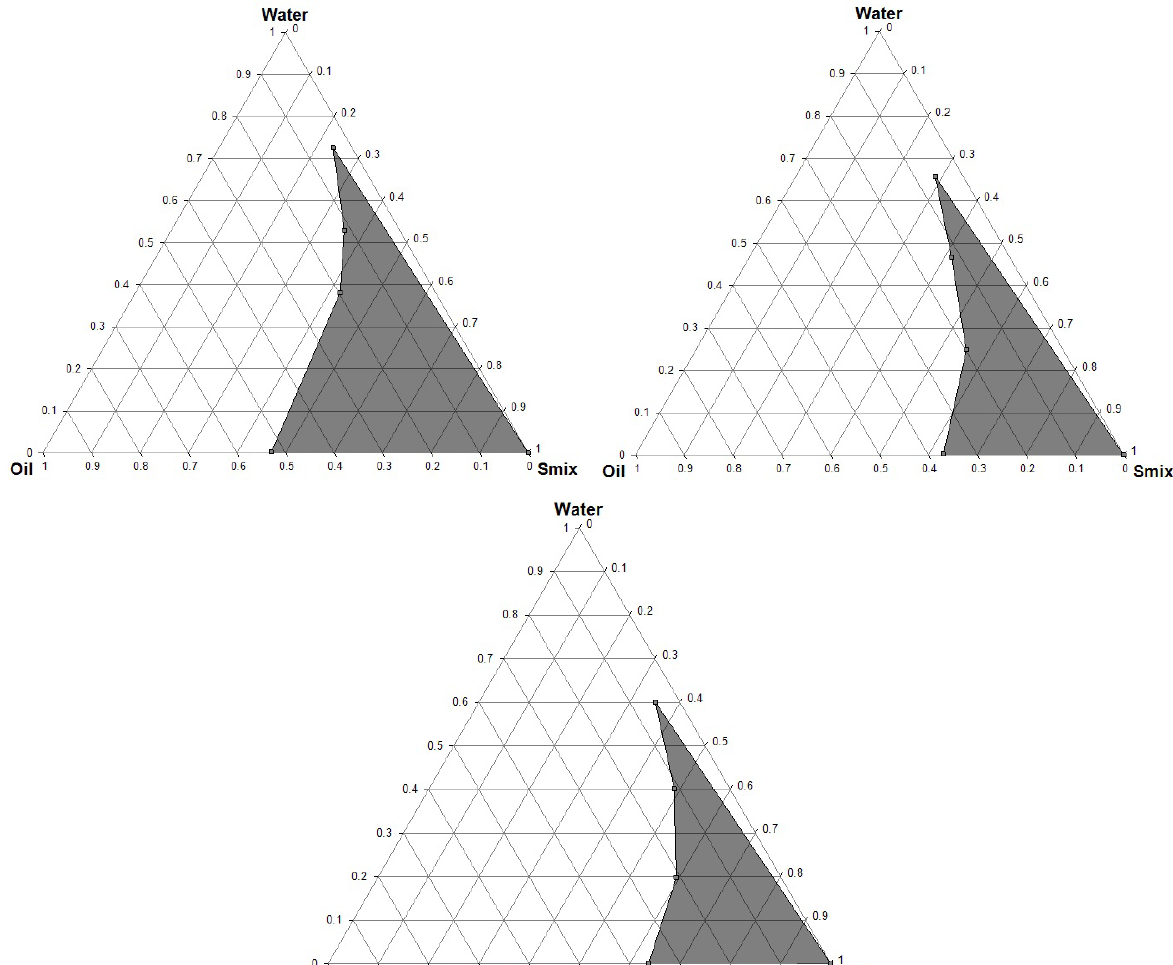
Figure 1. Pseudoternary phase diagrams of microemulsions using Smix at weight ratio a) 1:1 b) 1:3 and c)